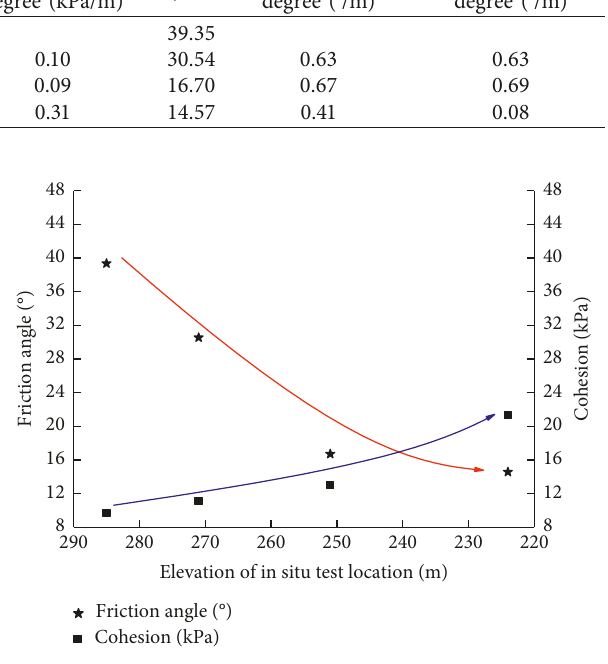
Figure 8: The evolution curve of cohesion and friction angle in in situ direct shear